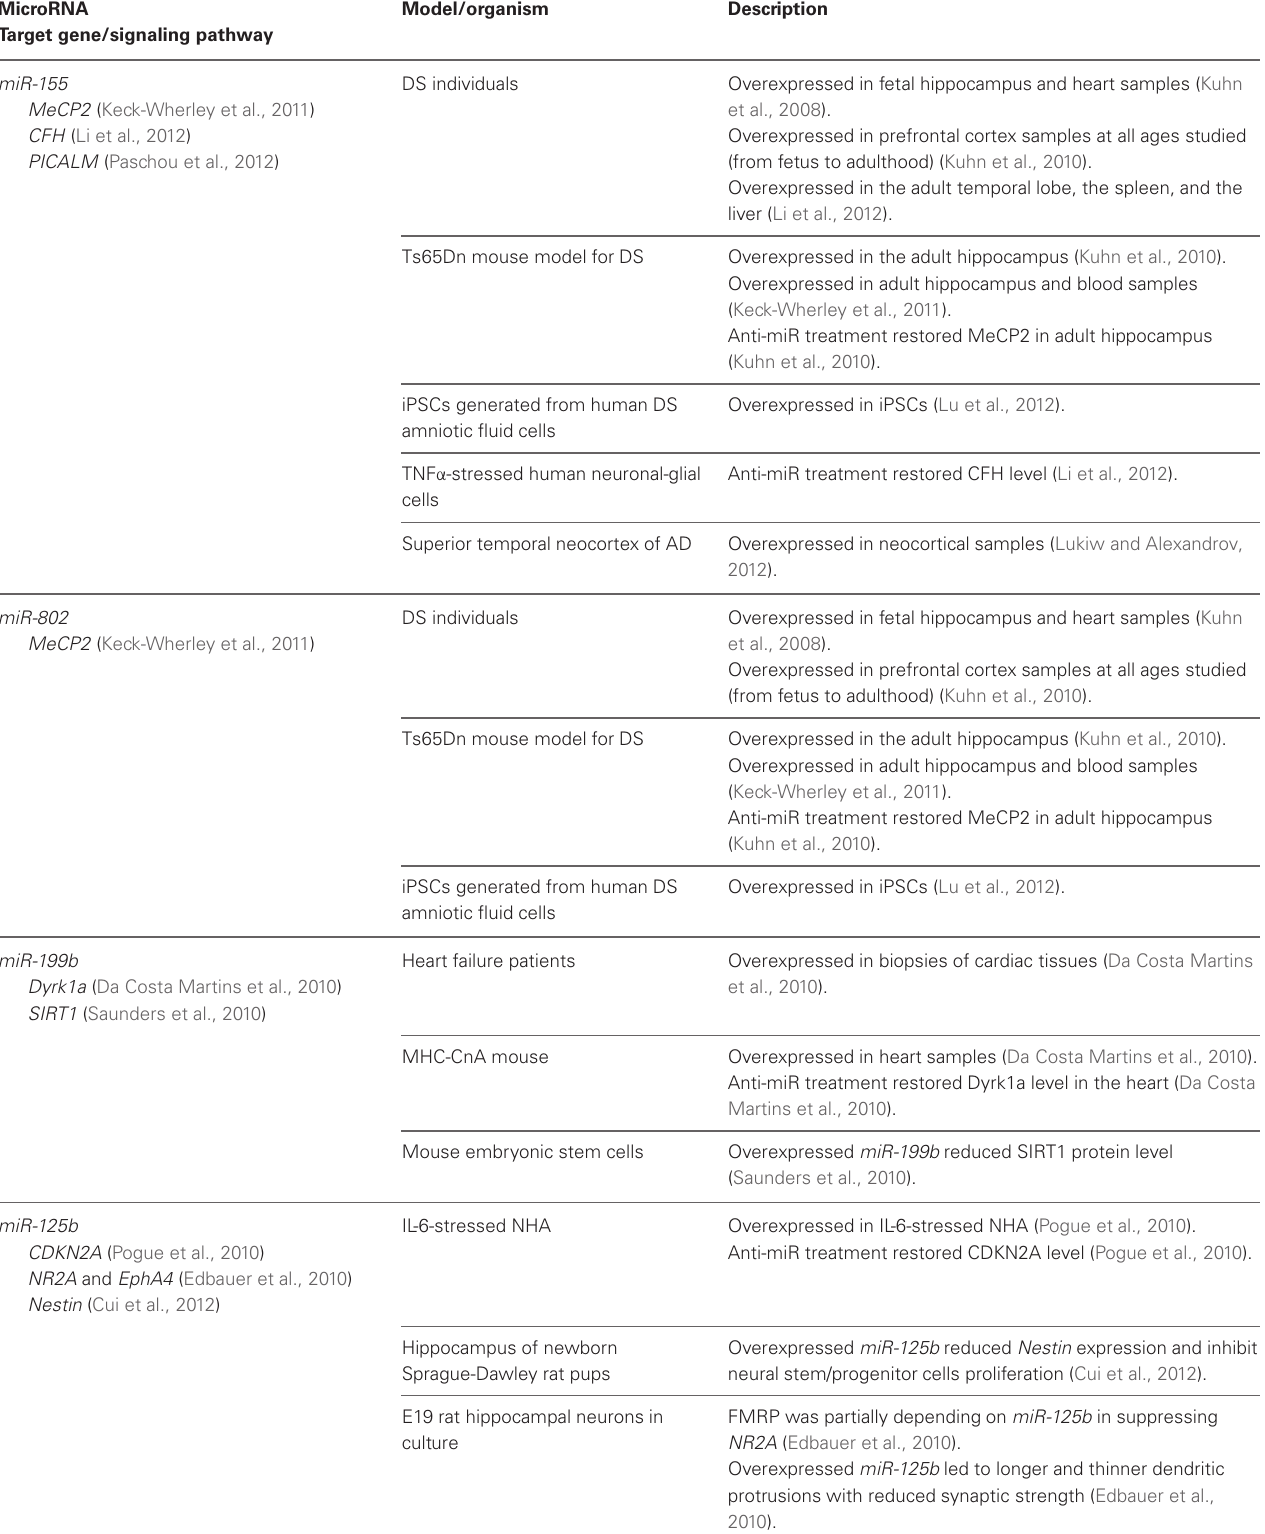
Table 1 | Summary of miRNAs that are associated with intellectual